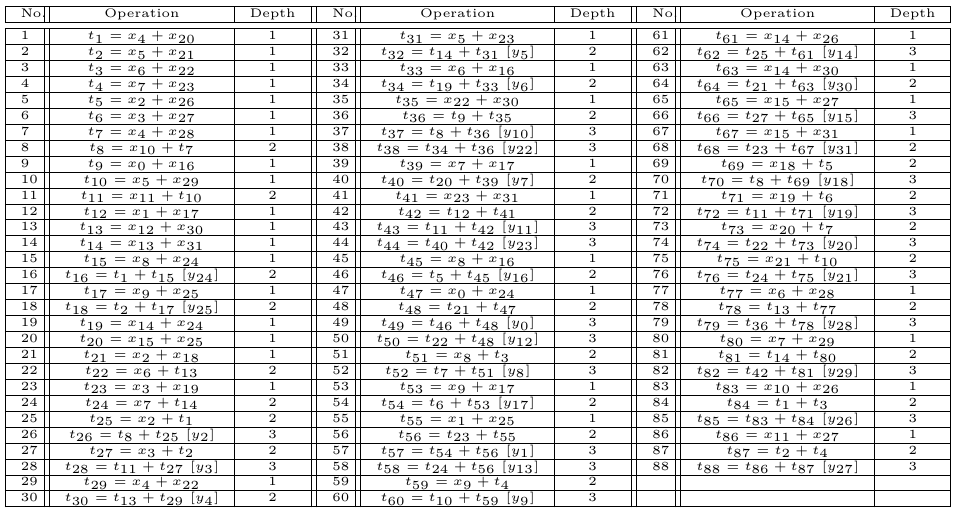
Table 6: An implementation of Q , corresponding to parameter (0 , − 2 , − 2 , 2 , 4 , 6), with 88 XOR gates and depth 3, where ( x 0 , · · · , x 31 ) are input signals, ( y 0 , · · · , y 31 ) are output signals, and t i ’s are intermediate